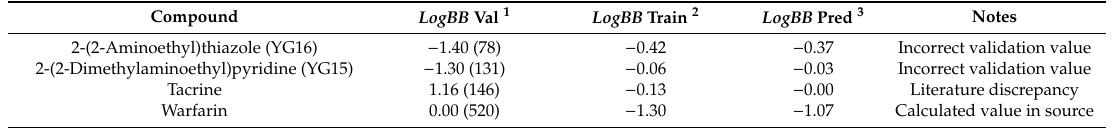
Table 2. Additional analysis of some outlier compounds.